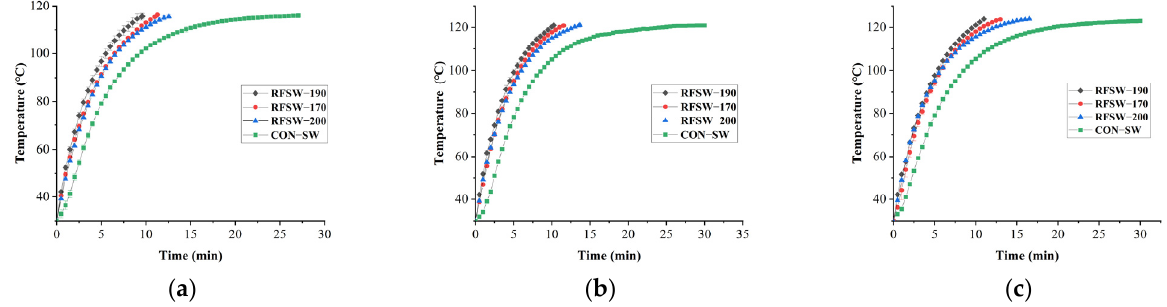
Figure 5. Time–temperature profiles of point C in poached spicy pork slices in different electrode gaps at 116 °C ( a ), 121 °C ( b ), and 124 °C ( c ). RFSW means radio frequency combined superheated water at an electrode gap; CON-SW means superheated-water sterilization without radio frequency energy. RFSW sterilization reduced at least half of the sterilization time, thereby reaching the target temperature compared with the CON-SW treatment. A greater slope difference between two curves of RFSW and CON-SW in a temperature was observed in the back part of the curve than in the front part, thereby showing that the electrode gap significantly increased the heating rate of the latter part of the heating process. As the temperature difference between PSPS and SW decreased, the mainstay of heat transfer impetus